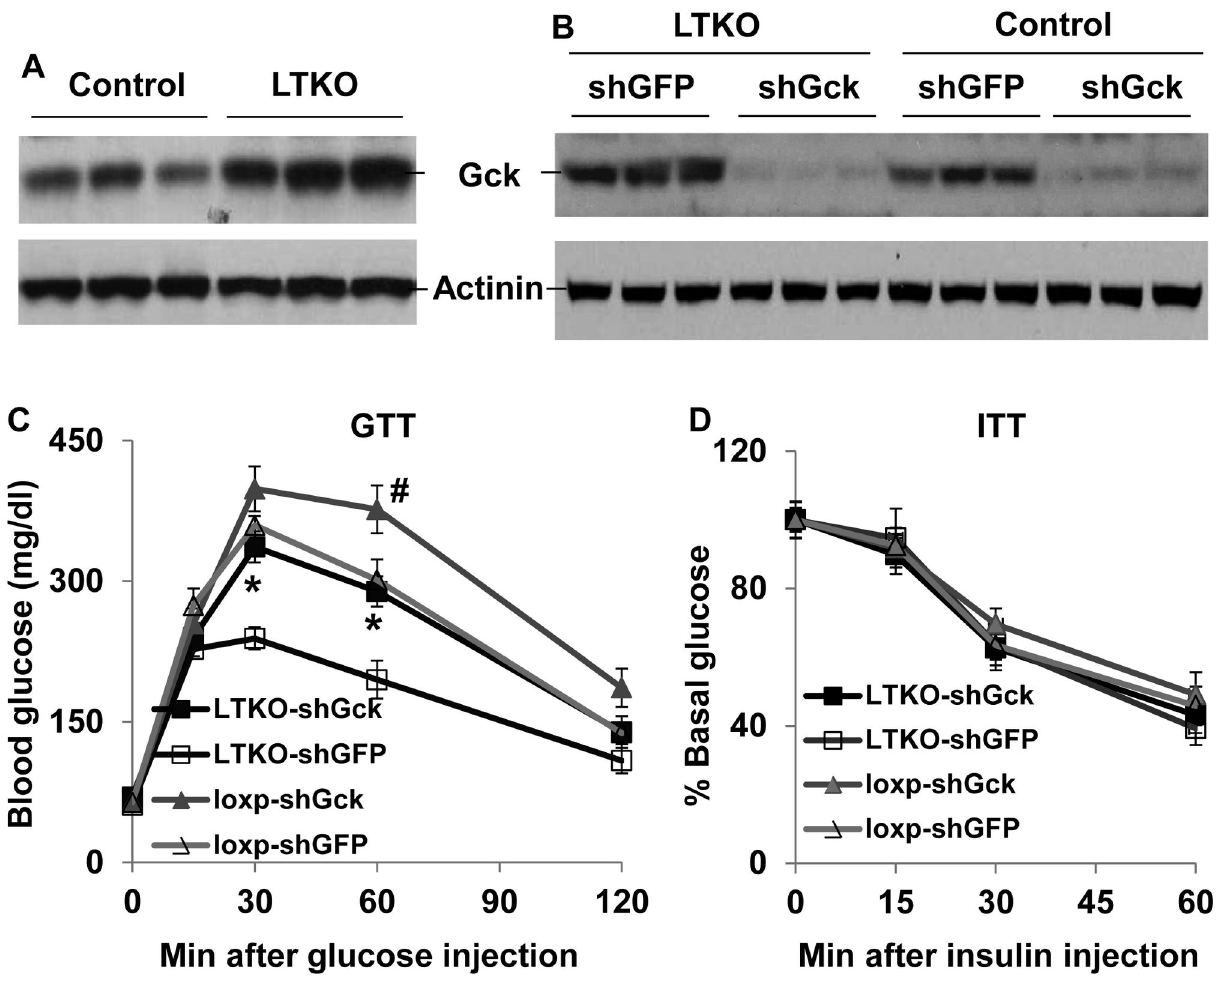
Figure 7. Gck knockdown impairs glucose tolerance in both wild-type and LTKO mice. (A) Gck protein was analyzed in the livers of 3-month-old control and LTKO mice by Western blots. (B) Gck knockdown was assessed by Western blots in liver lysates from control and LTKO mice injected with shGck or shGFP adenoviruses. (C, D) Glucose tolerance tests and insulin tolerance tests in 6-month-old male control and LTKO mice injected with shGck or shGFP adenoviruses (n=5-6), respectively. Data represent mean ± SEM. *, P <0.05 between LTKO-shGFP and LTKO-shGck groups; #, P <0.05 between loxp-shGFP and loxp-shGck groups.